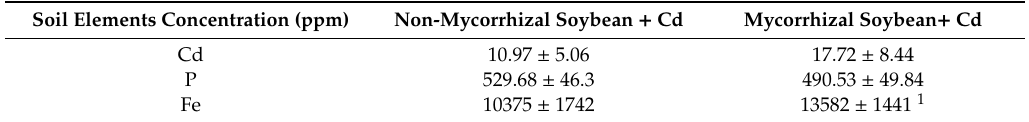
Table 2. Soil Cd, P, and Fe contents (ppm of soil) of non-mycorrhizal and mycorrhizal soybean plants after 40 days of Cd